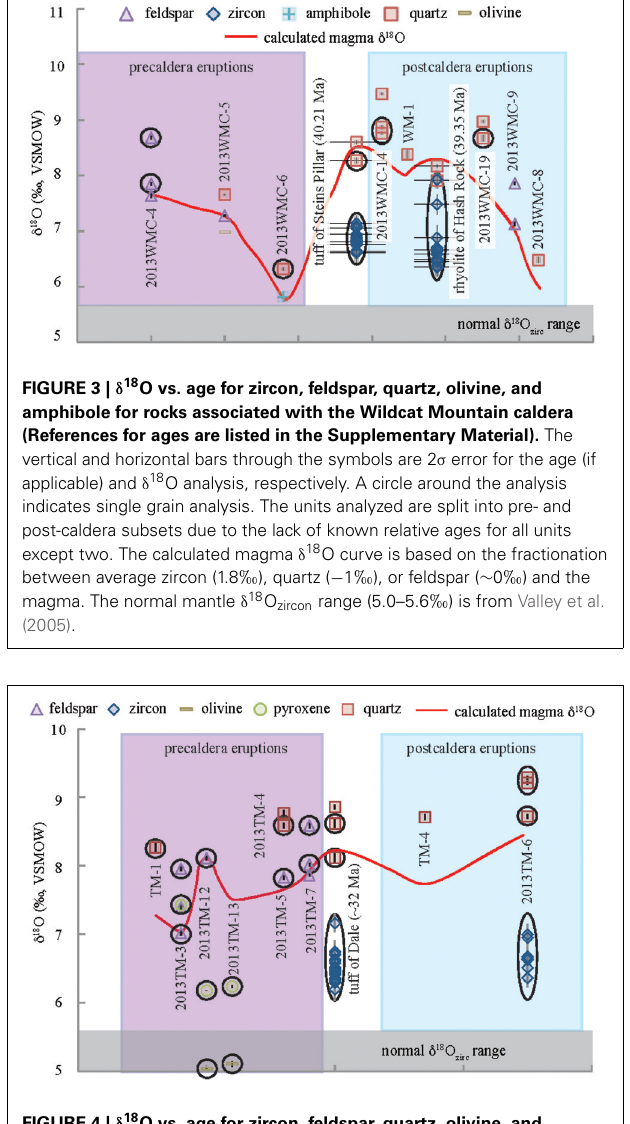
arc rocks worldwide (Johnson et al., 2009; Bindeman et